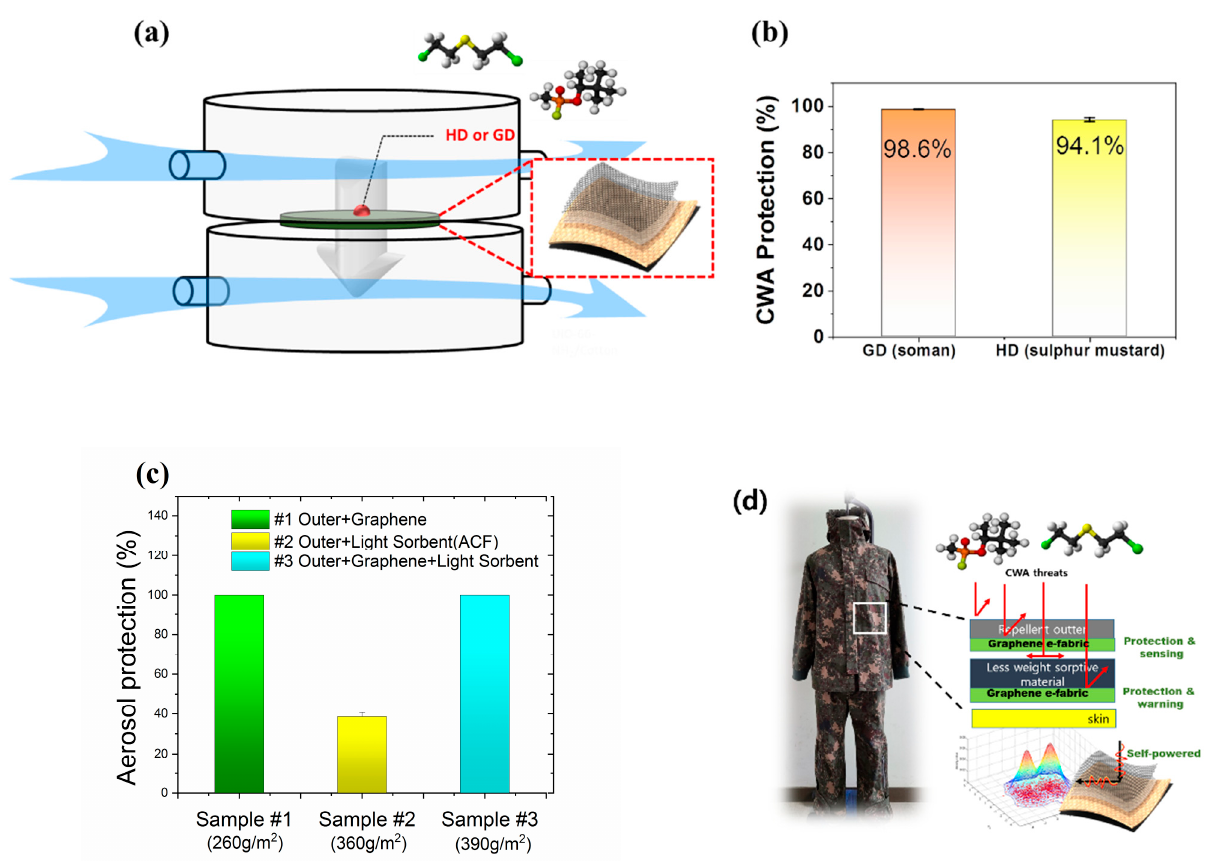
Figure 9. ( a ) Schematic of chemical warfare agent permeation test, ( b ) CWAs protection by graphene fabric, ( c ) 100 nm aerosol protection by protective clothing (#1 Outer layer + graphene, #2 Outer layer + light sorptive layer (activated carbon fiber), #3 Outer layer + graphene + light sorbent (activated carbon fiber), and ( d ) design concept of graphene intelligent multifunctional protective clothing.